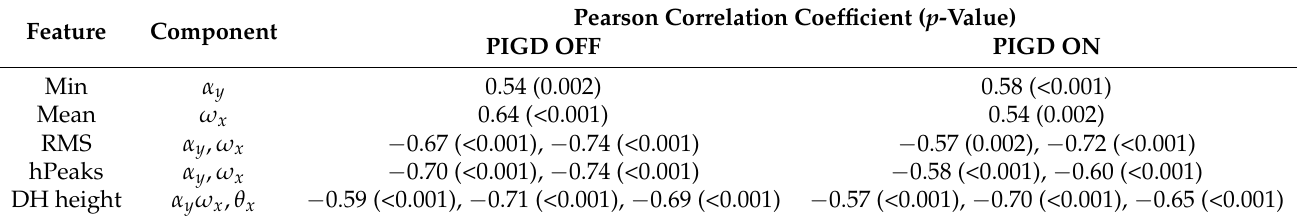
Table 6. Correlation between engineered features and PIGD score. Results are reported in terms of Pearson correlation coefficient and relative p-value. For each feature, significant components are reported. α : acceleration; ω : angular velocity; θ :